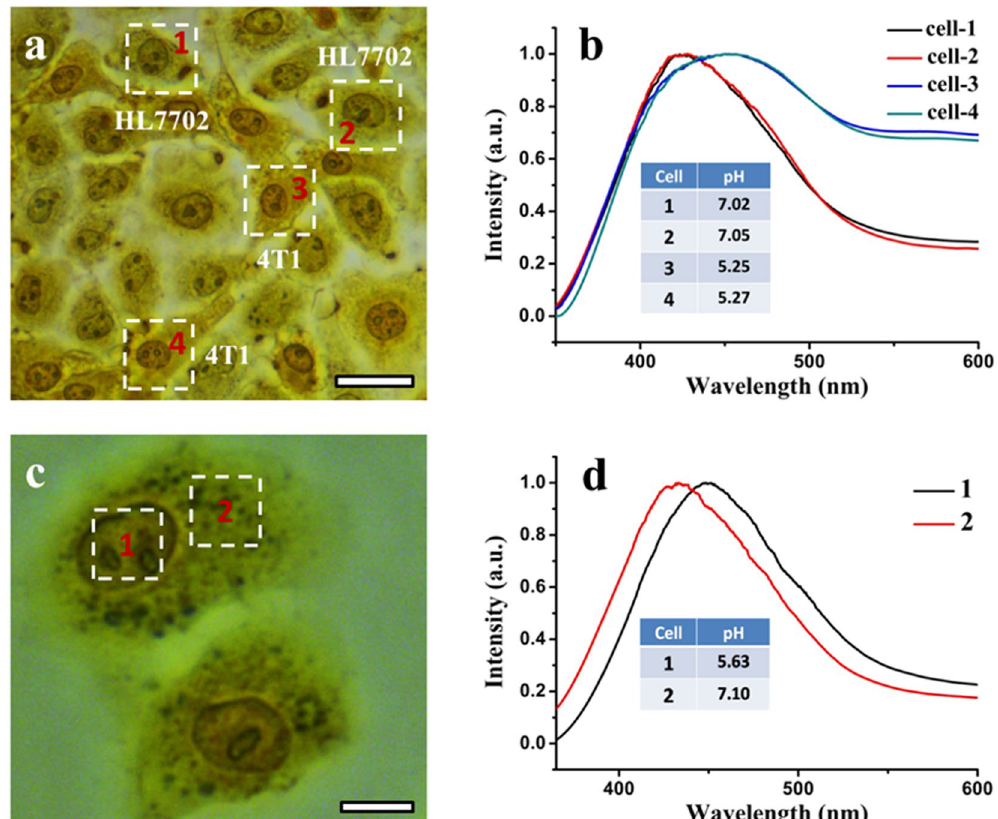
Figure 5. Cancer cell identification from cocultured normal cells by pH imaging and detection, and sub- cellular pH detection. ( a ) A bright-field optical microscope image of the cocultured HL7702 and 4T1 cells treated with bromothymol blue. Four intact single cells (with corresponding spectrum acquisition area marked by a dotted white square) were randomly selected for single-cell pH detection. Scale bar: 20 μ m. ( b ) Corresponding normalized bright-field microscope-based single-cell absorption spectra of the four selected cells as denoted in ( a ). ( c ) A bright-field optical microscope image of 1L929 cells treated with bromothymol blue. A single L929 cell marked by two dotted white squares (in different parts of the cell) was selected for sub- cellular pH detection. Scale bar: 10 μ m. ( d ) Corresponding normalized sub-cellular absorption spectra of the L929 cell taken from the two different parts of the cell as denoted in ( c